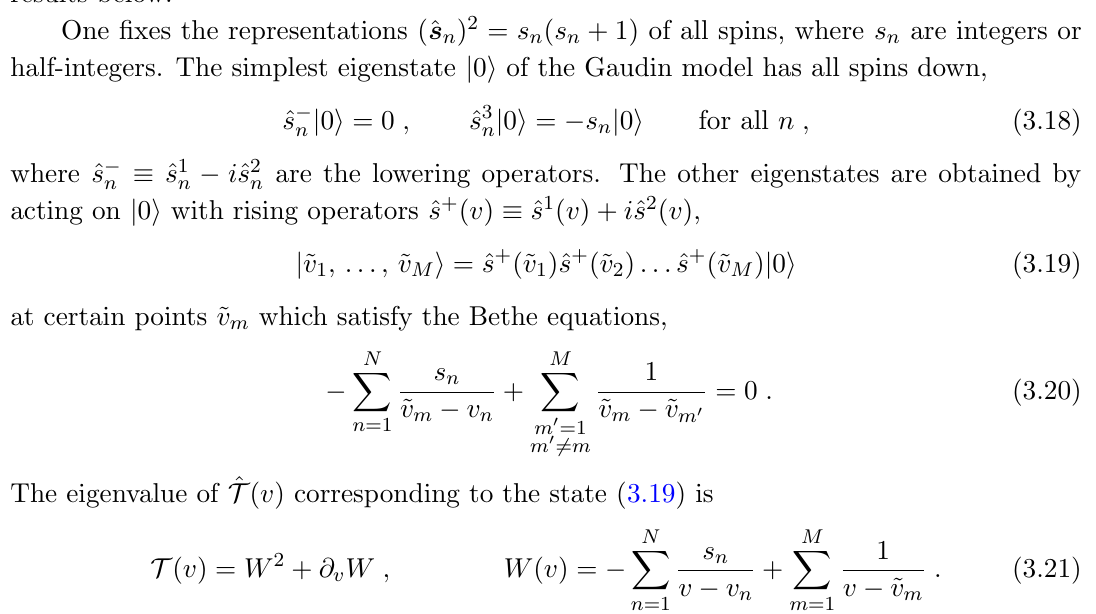
Table 2 . Correspondence between solitons in dilaton gravity and eigenstates of the Gaudin model. A complete set of eigenvectors and eigenvalues in the model (3.16) is provided by the algebraic Bethe Ansatz [47{49]. We review this method in appendix B and list its main results